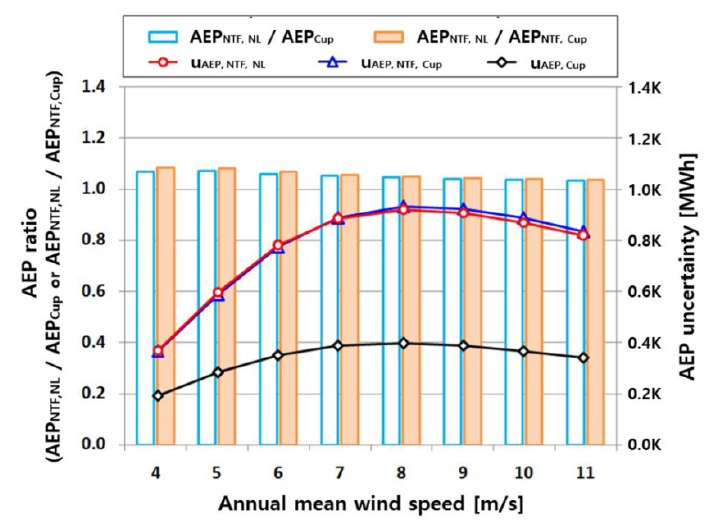
Figure 10. Comparison of the AEP ratio and AEP uncertainties.